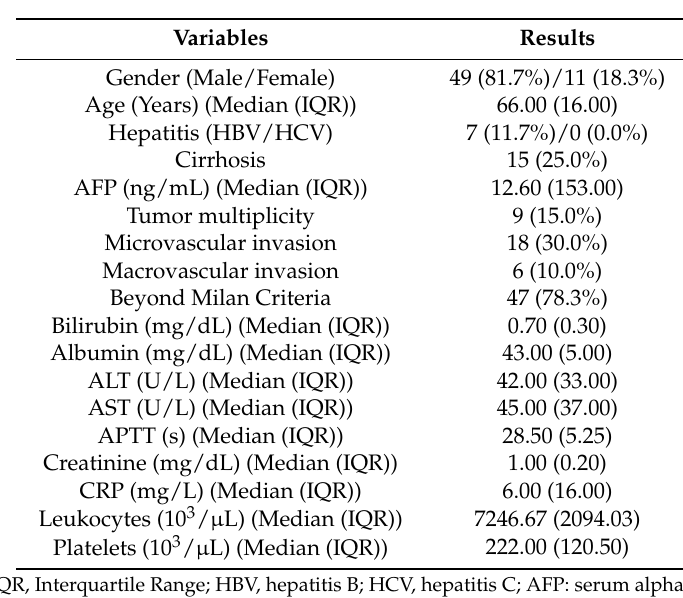
Table 1. Demographics of the Study Population.